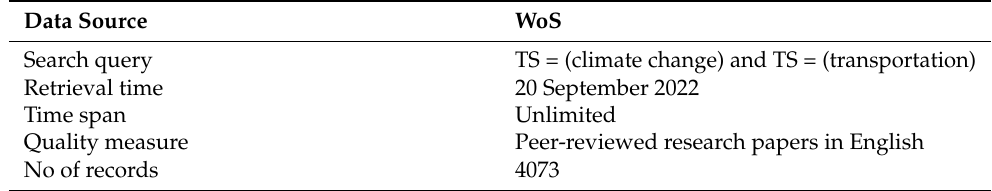
Table 1. The search query used in this